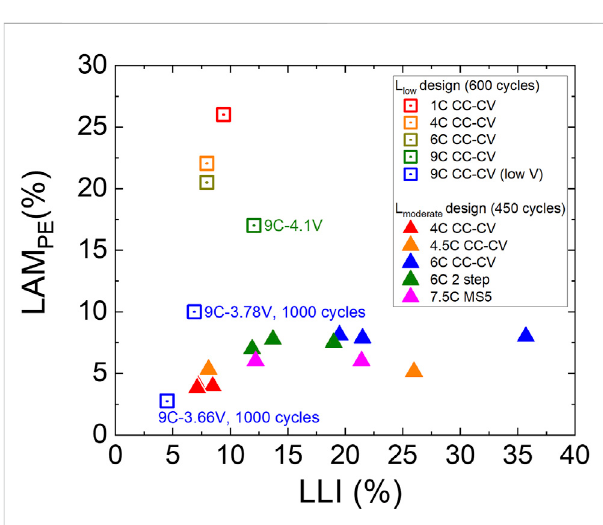
FIGURE 3 Scattering plot showing the amount of LLI and LAM PE at the end of cycling life of represented cells with different charge protocols. LAM PE is more signi fi cant in L low designs, while LLI is prominent in the L moderate cells. CC-CV, 2 step, and MS5 represent various charge protocols, which is described in and Supporting Information 1. All the cells are charged to 4.1 V except for 2 cells are charged to 3.78 and 3.66 V, respectively (marked with “ low V ” in the legend). More details about the cell ’ s behavior can be found in previous publications (Paul